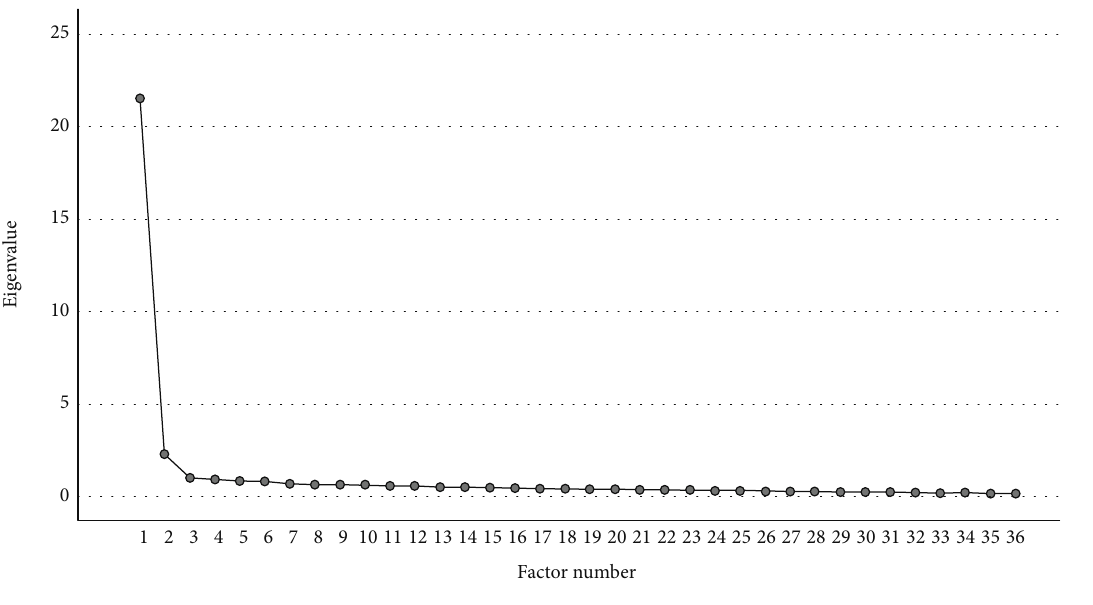
Figure 1: Exploratory factor analysis fi gure showing the factor number on the horizontal axis and the eigenvalue on the vertical